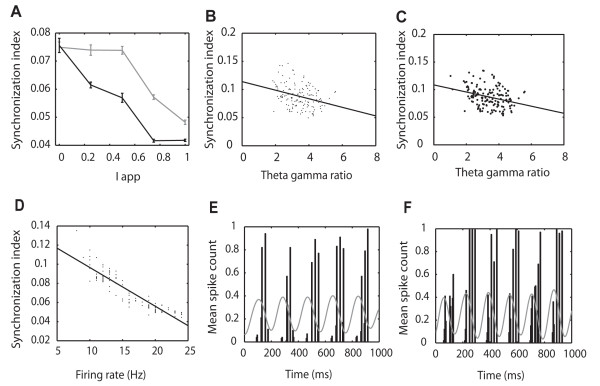
Learning-associated desynchronization in model excitatory neurones and IT. Graphs show (A) Significantly greater desynchronization of the 100 excitatory neurons in the model as a function of stimulus strength (Iapp) after learning (black) compared with during it (grey) (using an overall mean for all Iapp values t18 = -5.30, p < 0.0001). Data are mean ± sem from 10 runs. (B) Negative correlation between synchronization and the theta/gamma ratio in MUA recordings from IT (r = -0.32, p < 0.001), (C) Negative correlation between excitatory neuron synchronization and size of the theta/gamma ratio, r = -0.42, p < 0.001, (D) Negative correlation between synchronization index and firing rate of the downstream neuron r = -0.60, p < 0.001, (E) Firing frequency distribution and theta waves generated by the model's 100 excitatory neurons in 5 ms bins for 1s after stimulus onset during learning and (F) after learning (Iapp = 0.8). After learning more time bins during theta waves have active neurons compared with before learning as a result of greater desynchronization. NMDA, AMPA and GABA A receptor coefficients as in Figure 8.